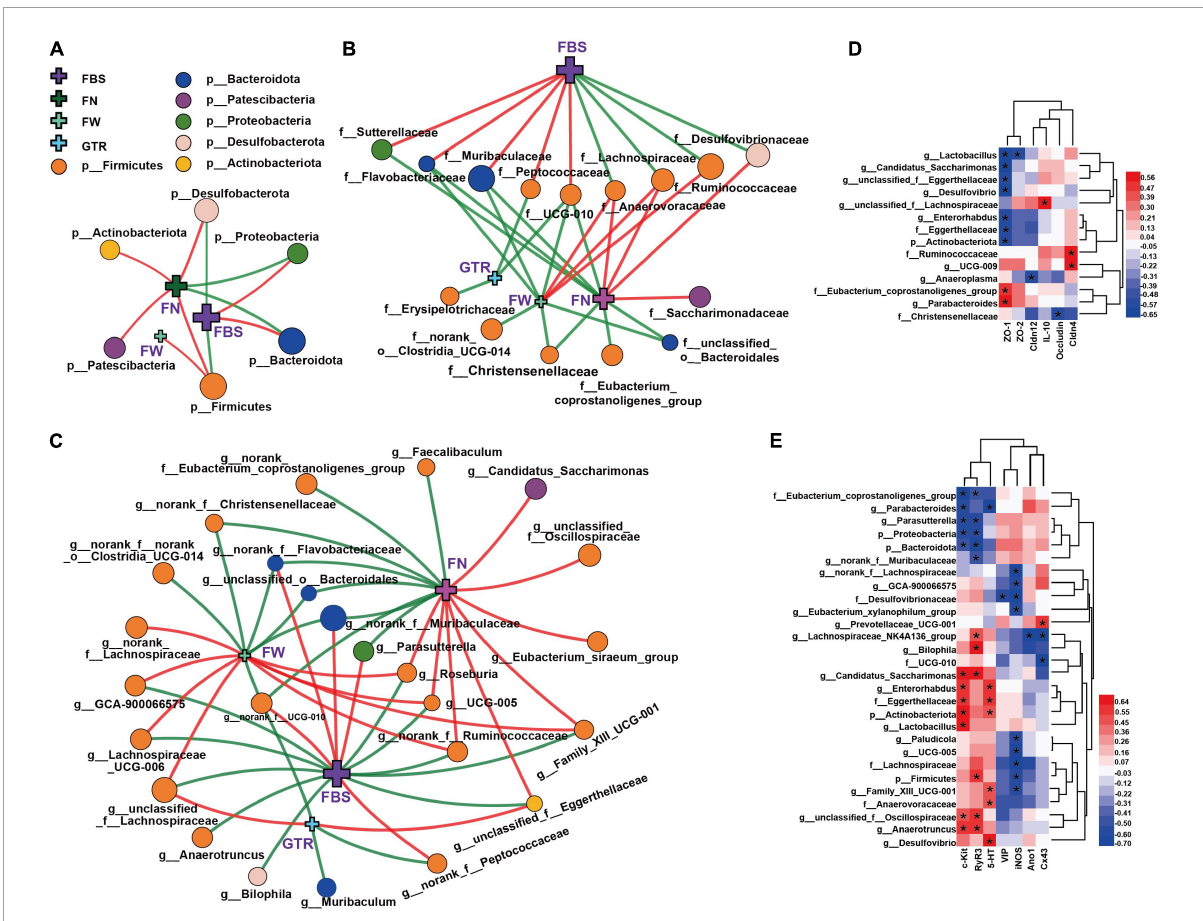
FIGURE6 Network and heatmaps showing correlations between specific gut bacteria and core host parameters in STC mice. (A–C) Two-factor correlation network analysis ( P < 0.05; Spearman, n = 6 in each group). Red lines represent r values ≥ 0.4, and green lines represent r values ≤ 0.4. Correlations between gut bacteria and the laxative phenotypic indicators, including (A) at the phylum level, (B) at the family level, and (C) at the genus level. FBS, the defecation time of the first black stool; the wet weight of the feces (FW) and the number of feces excreted in 6 h (FN); the gastrointestinal transit rate (GTR). (D,E) Bivariate correlations ( P < 0.05, n = 6 in each group), including correlations between gut bacteria and intestinal inflammation, gut barrier function in the colon of mice (D) , correlations between gut bacteria and serum neurotransmitters, gastrointestinal motility factors (E) . IL-10 , ZO-1 , ZO-2 , Cldn4 , Cldn12 , Occludin , c-Kit , SCF , Ano1 , and Cx43 indicate their mRNA expression levels in the colons of mice. 5-HT, iNOS, and VIP indicate their expression levels in serum. The color at each intersection indicates the value of the r coefficient; P -alues were adjusted for multiple testing according to the Bonferroni and Hochberg procedures. * Indicates a significant correlation between these two